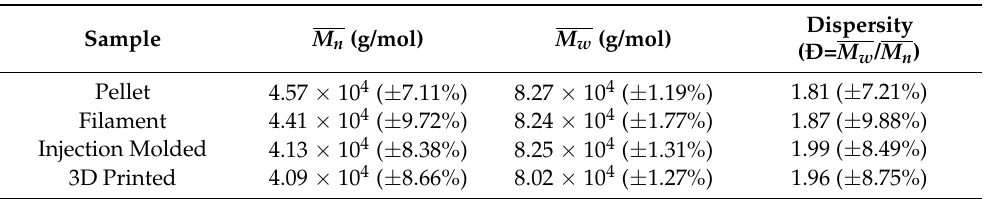
Table 4. Number ( M n ) and weight ( M w ) averaged molecular weights and dispersity index (Ð) for pellet and processed PVDF